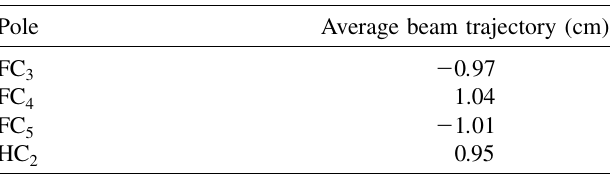
TABLE III. Average beam trajectory in the poles of the wig- gler at positive z .